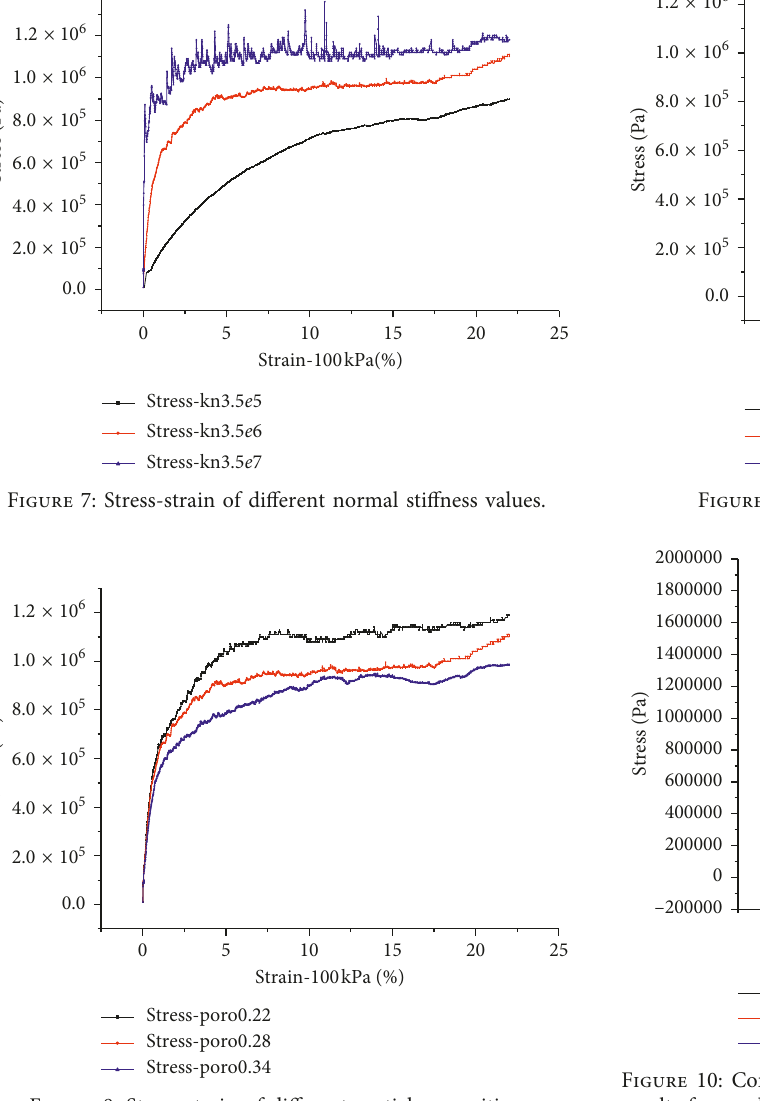
Figure 8: Stress-strain of different particle porosities.